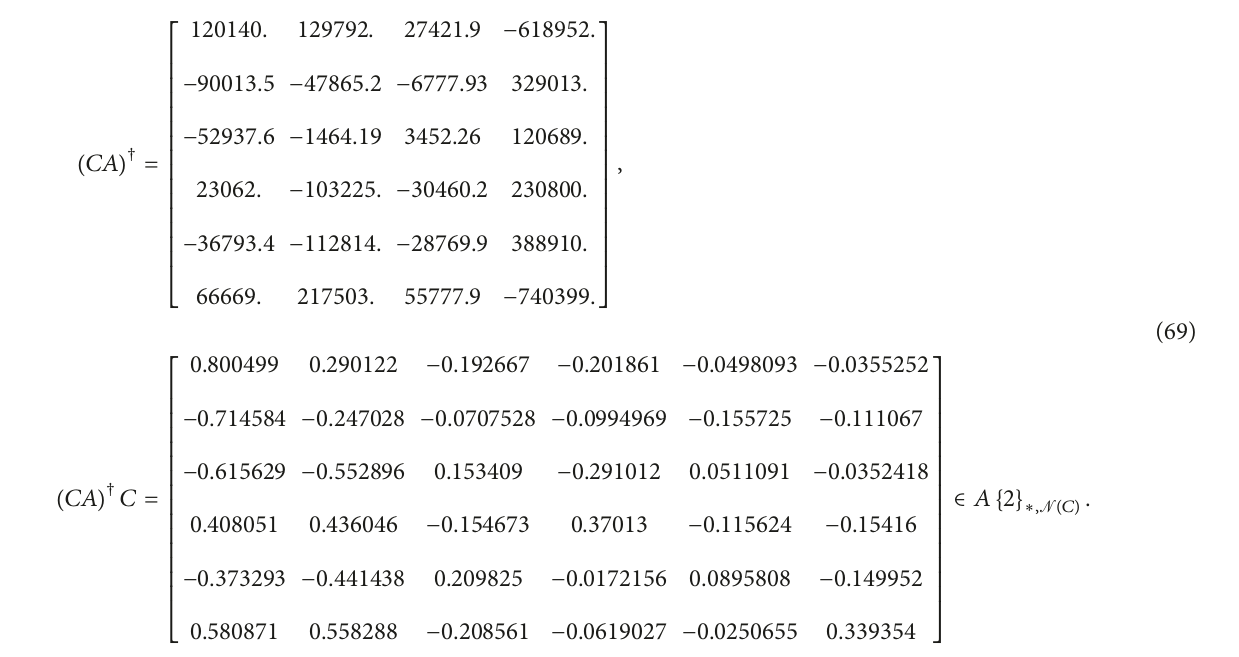
𝐶(𝑡)𝐴(𝑡)𝑉(𝑡)𝐶(𝑡) = 𝐶(𝑡) gives the result which is presented in Figure 6. The display denoted by 𝑉(𝑡) represents an approxi- mation of 𝑉(𝑡) . The display denoted by 𝐴𝑇𝑆2 represents the matrix product 𝑋 = 𝑉(𝑡)𝐶(𝑡) . The time interval is [0, 1] and the solver is ode15s . The activation is achieved by the power- sigmoid function. The corresponding outer inverse of 𝐴 is 𝑋 = 𝑉𝐶 ∈ 𝐴{2} ∗, N (퐶)